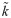
Illustration of the SubPPM approach.instead of computing possibly intractable POIMs for long motifs directly, we decompose each of the longer motifs (here: a single motif of length 12) into smaller overlapping, conforming subsequences of length k˜ (in the figure: k˜=3). This approach allows us to reconstruct motifs of arbitrary length using low dimensional POIMs, rendering the reconstruction of very large, possibly overlapping motifs computationally feasible.